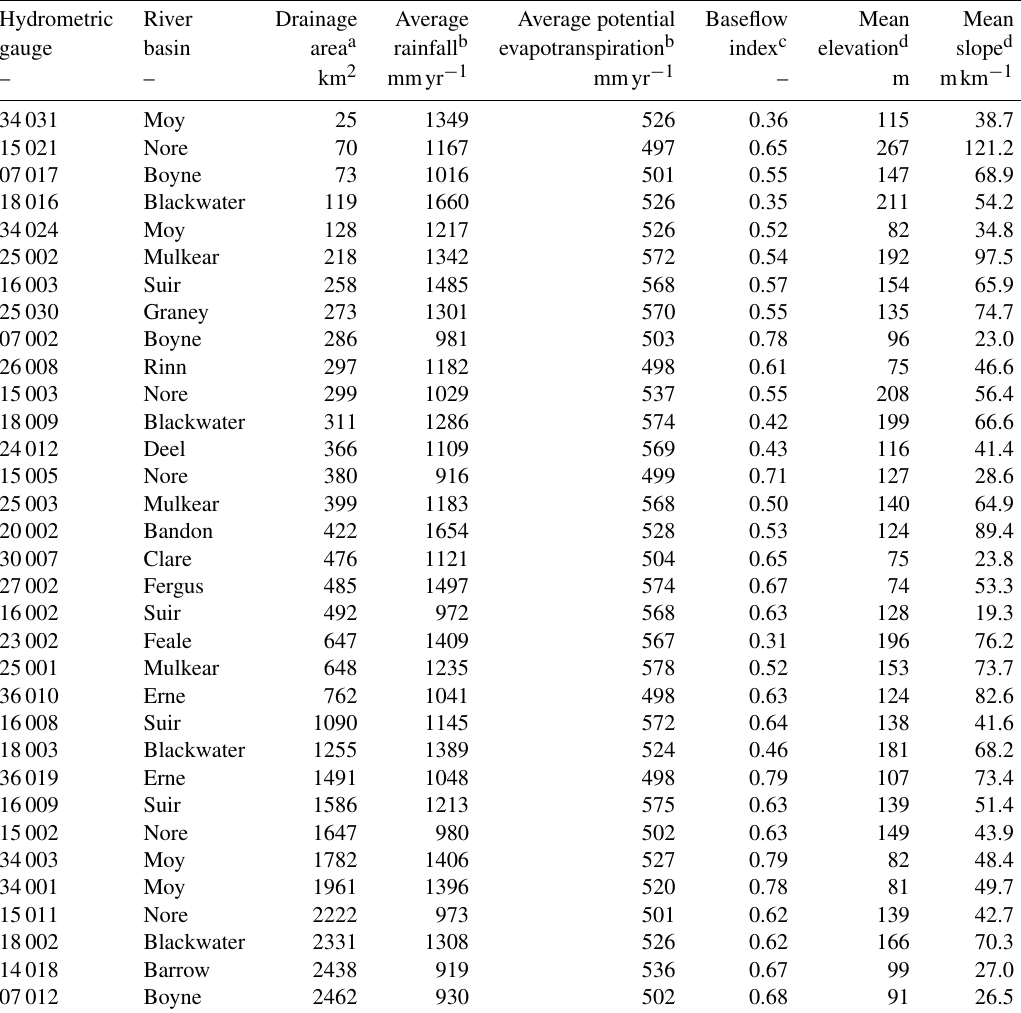
Table A1. List and main characteristics of the 33 study